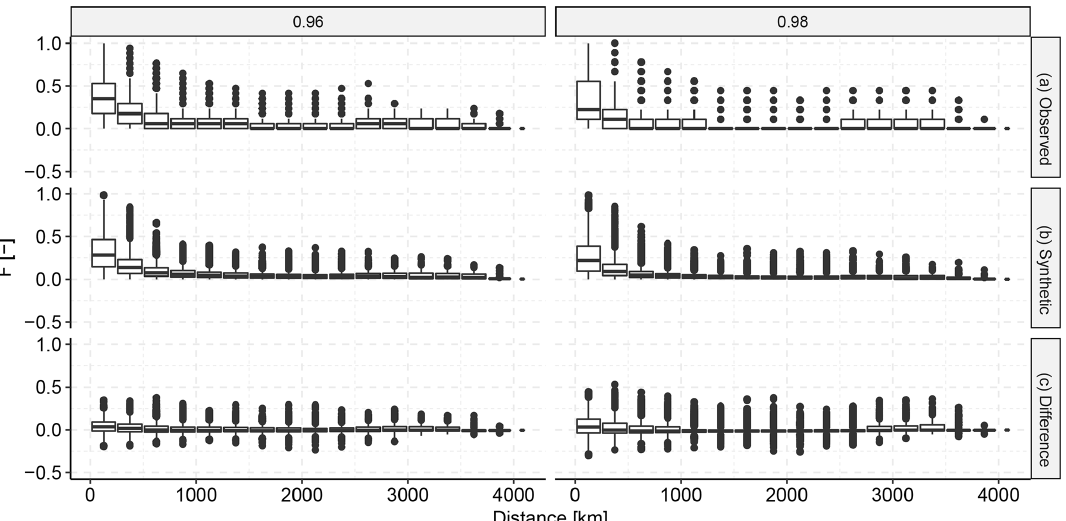
Figure 9. Spatial extremal correlation of the observed descriptors vs. the synthetic descriptors. For a selection of high quantiles we counted the fraction F of events for which extremes at both locations exceeded the respective quantile divided by the total number of quantile exceedances. Panel (a) shows the fractions in the observed data, (b) shows the fractions in the synthetic data and (c) shows the pairwise difference between the observed and the synthetic